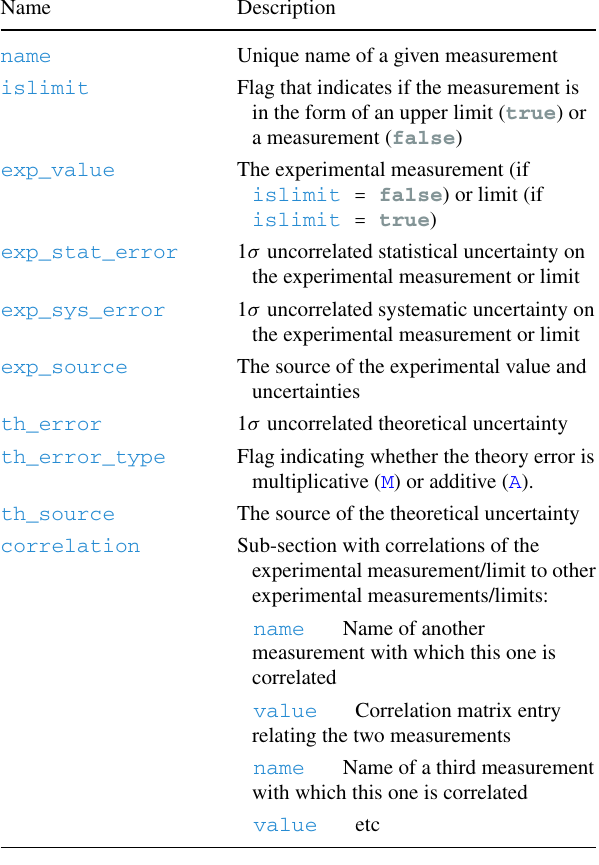
Table6 Parametersofasingleexperimentalentryinthe